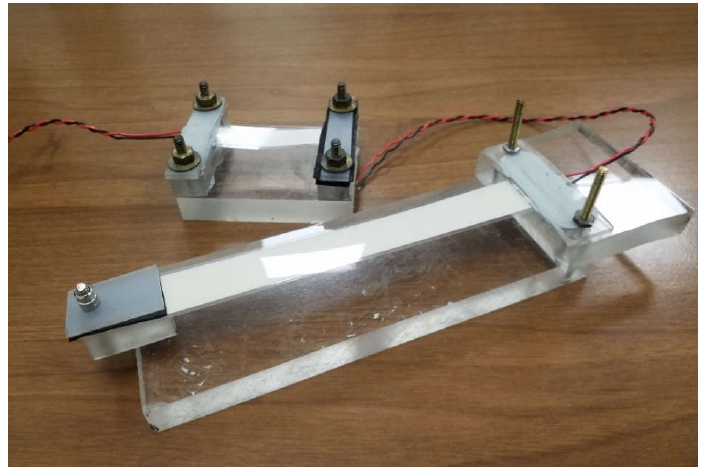
Figure 4. Piezoelectric structures: a 2.9 cm long cantilever. Red wire is connected to the oscilloscope and black to mass. The structure can be inserted into a 2 m long pole, thus testing the energy impact from 0.5–2 m in height.